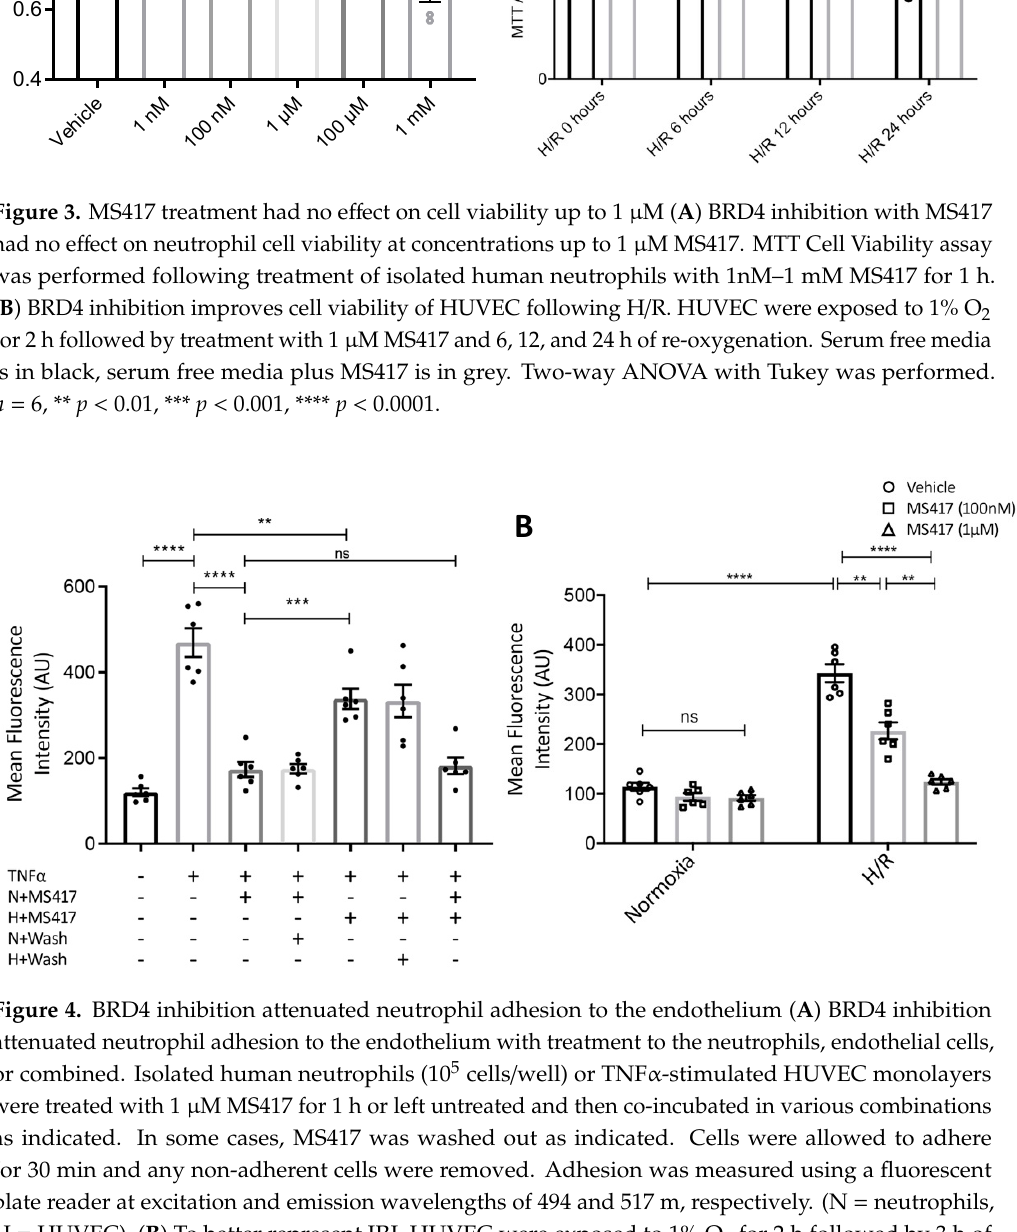
Figure 3. MS417 treatment had no effect on cell viability up to 1 μ M ( A ) BRD4 inhibition with MS417 had no effect on neutrophil cell viability at concentrations up to 1 μ M MS417. MTT Cell Viability assay was performed following treatment of isolated human neutrophils with 1nM–1 mM MS417 for 1 h. ( B ) BRD4 inhibition improves cell viability of HUVEC following H/R. HUVEC were exposed to 1% O 2 for 2 h followed by treatment with 1 μ M MS417 and 6, 12, and 24 h of re-oxygenation. Serum free media is in black, serum free media plus MS417 is in grey. Two-way ANOVA with Tukey was performed. n = 6, ** p < 0.01, *** p < 0.001, **** p < 0.0001.